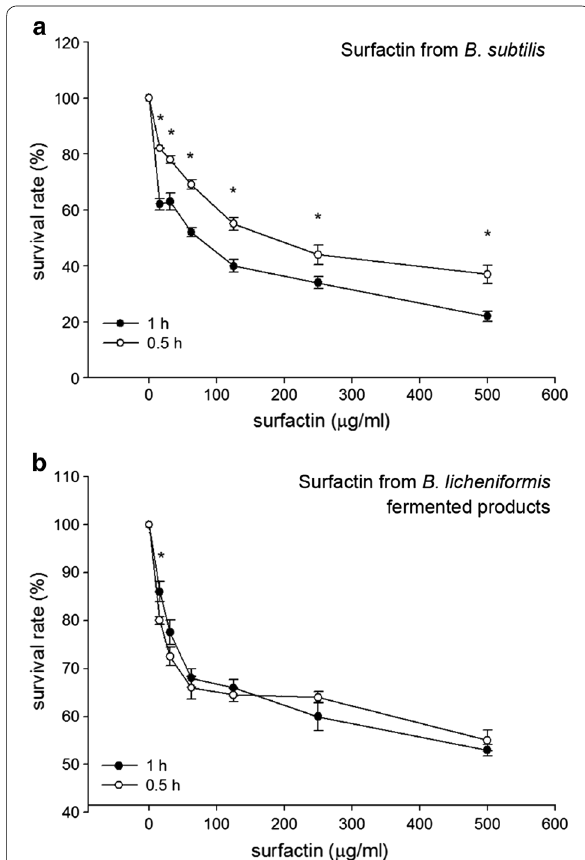
Fig. 2 Killing activity of surfactin against B. hyodysenteriae . a B. hyodysenteriae were incubated with different concentrations (9.31, 18.63, 37.25, 62.5, 125, 250, 500 μg/ml) of the B. subtilis ‑derived surfactin for 0.5 and 1 h. b B. hyodysenteriae were incubated with different concentrations (9.31, 18.63, 37.25, 62.5, 125, 250, 500 μg/ml) of the B. licheniformis ‑fermented product‑derived surfactin for 0.5 and 1 h. The error bars represent the mean standard deviations from ± triplicate assays (n 3). * P < 0.05 comparing data of 0.5 h versus 1 h =